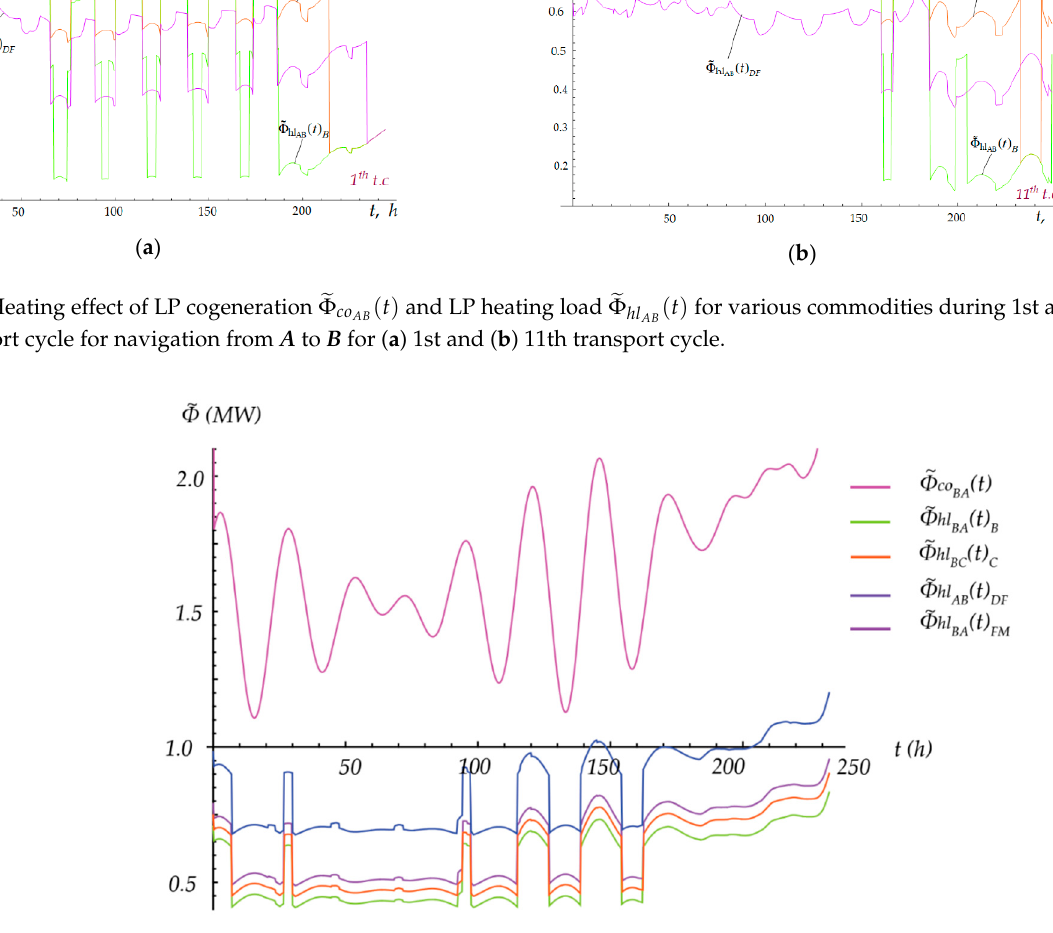
( b ) t Φ  and LP heating load ( ) t Φ  for various commodities during 1st AB co AB hl